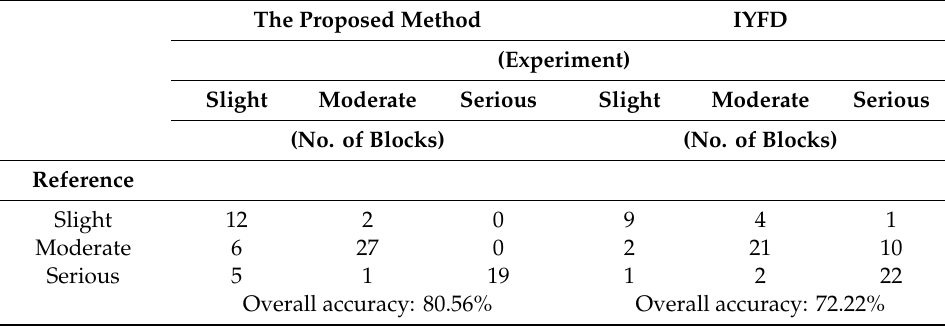
Figure 16. BDA results of the Yushu urban area at the scale of city block. The misclassification blocks Table 1. Accuracy evaluation of the BDA for the proposed method and IYFD are the numbered blocks with nos. 1–14, and the color of the colored numbers stands for the color of the correct BDA. The block with black no. 15 is the area where the OB are clustered. Table 1. Accuracy evaluation of the BDA for the proposed method and IYFD method.